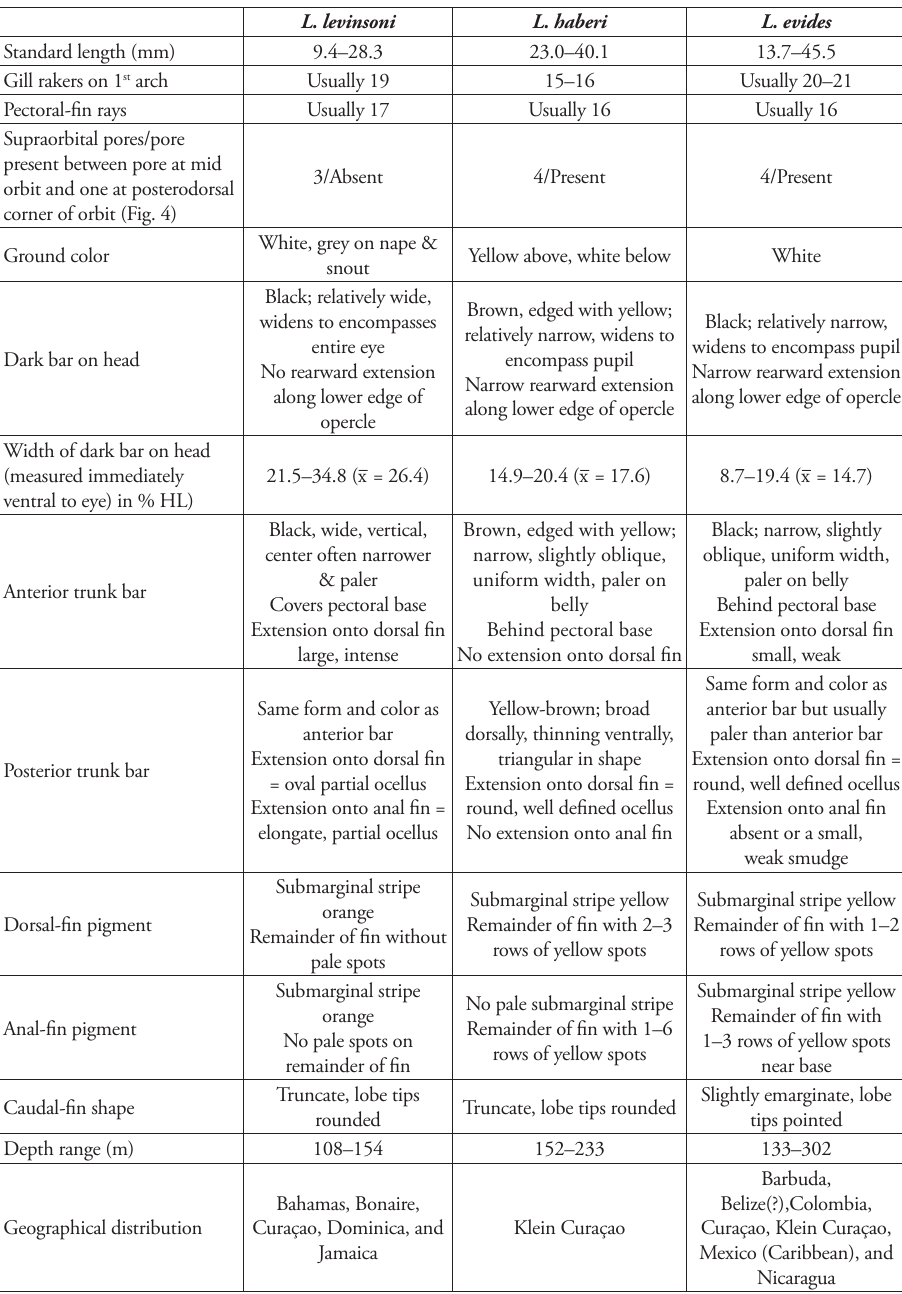
Table 5. Comparisons among Lipogramma levinsoni sp. n., L. haberi sp. n., and L. evides